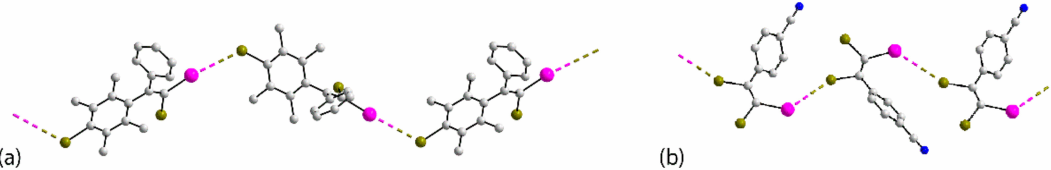
Figure 7. One-dimensional, linear chains in the crystals of ( a ) 12 and ( b ) 20 . The next series of one-dimensional chains has I · · · Br interactions within a zigzag topology, as found in the crystals of 21 [61], 22 [62], 23 [63], 24 [64], 25 [65] and 26 [66]. The common crystallographic features of the solvent-free crystals, with the exception of 25 , are the presence of a single molecule in the asymmetric unit and the generation of the zigzag chain by glide symmetry. In 25 , the two independent molecules associate into a two-molecule aggregate with the chain propagated by glide symmetry. The crystals of 21 , 22 , Figure 8a, and 23 feature electrophilic iodide atoms. The remaining zigzag chains, that is, in crystals 24 [64], 25 [65] and 26 [66], do not exhibit great differences between the chain in 26 is shown in Figure 8b.